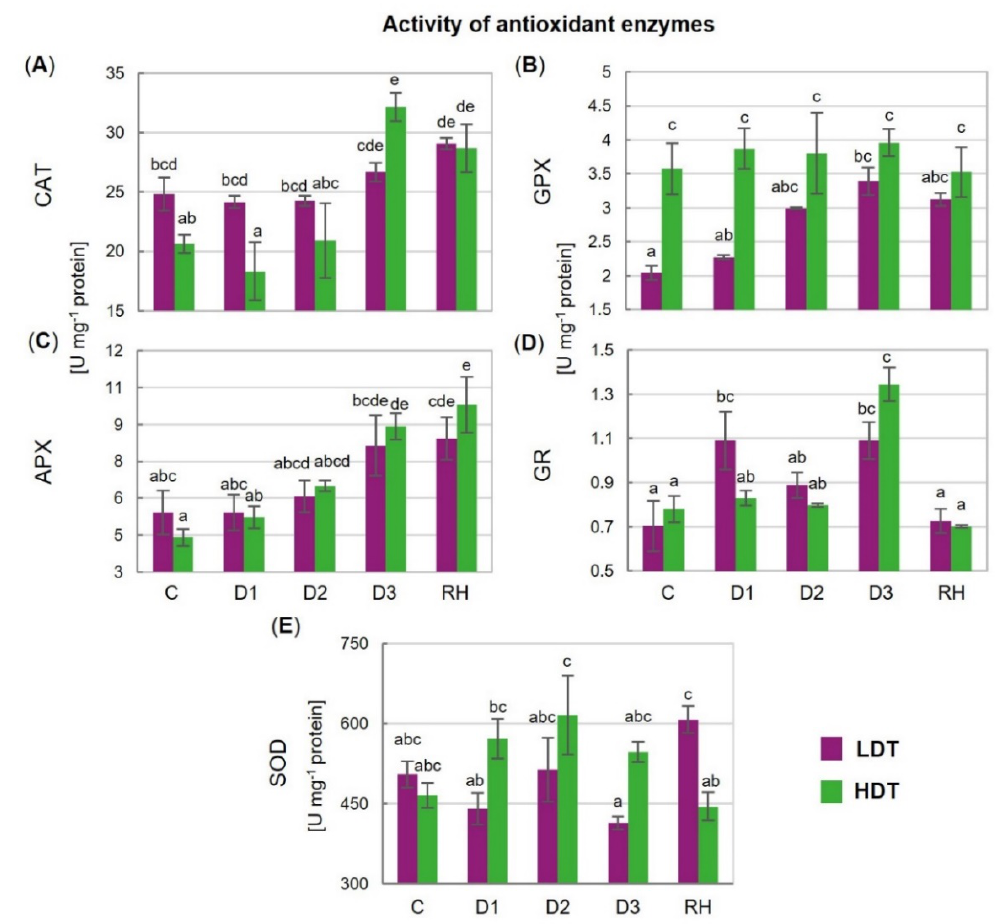
Figure 5. ( A ) Activity of catalase (CAT), ( B ) glutathione peroxidase (GPX), ( C ) L-ascorbate peroxidase (APX), ( D ) glutathione reductase (GR), and ( E ) superoxide dismutase (SOD) in two L. multiflorum / F. arundinacea introgression forms (low- and high-drought tolerant—LDT and HDT, respectively) before stress treatment (C), on the 3rd (D1), 6th (D2), and 10th (D3) day of water deficit and 10 days after re-hydration (RH). Error bars represent the standard errors. Homogeneous groups are denoted by the same letter according to Fisher’s LSD test ( p = 0.01).